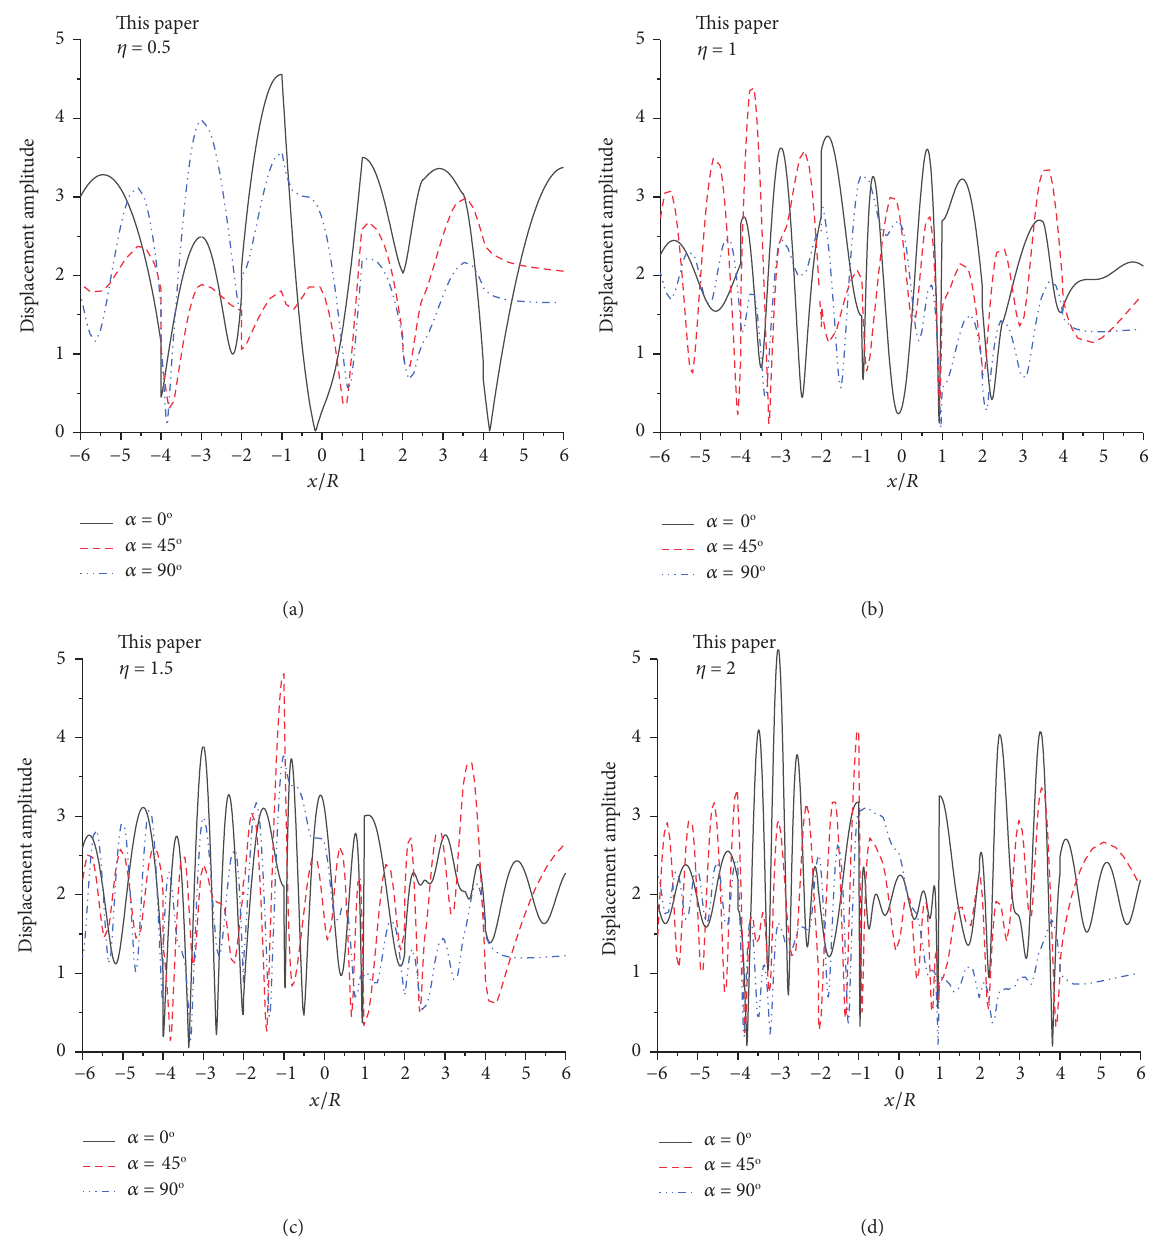
Figure 5: Surface displacement amplitude with the change of η . (a) Surface displacement amplitude at η � 0 . 5. (b) Surface displacement amplitude at η � 1. (c) Surface displacement amplitude at η � 1 . 5. (d) Surface displacement amplitude at η �